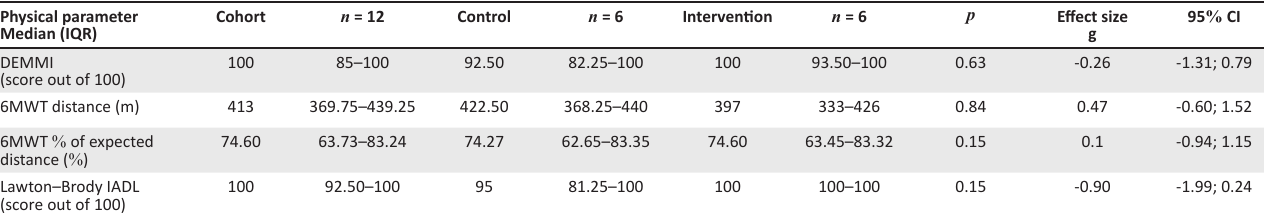
TABLE 4: Comparison of physical parameters as measured with follow-up. Physical parameter Cohort n = 12 Control n = 6 Intervention n = 6 Median (IQR)